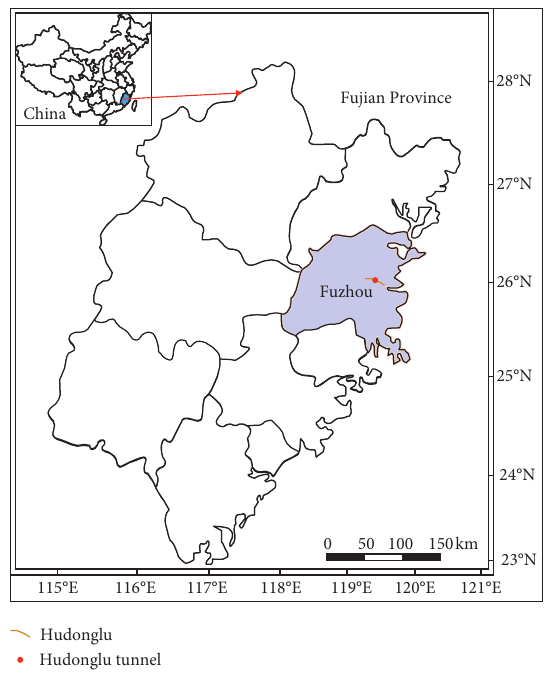
Figure 2: Position of Hudonglu